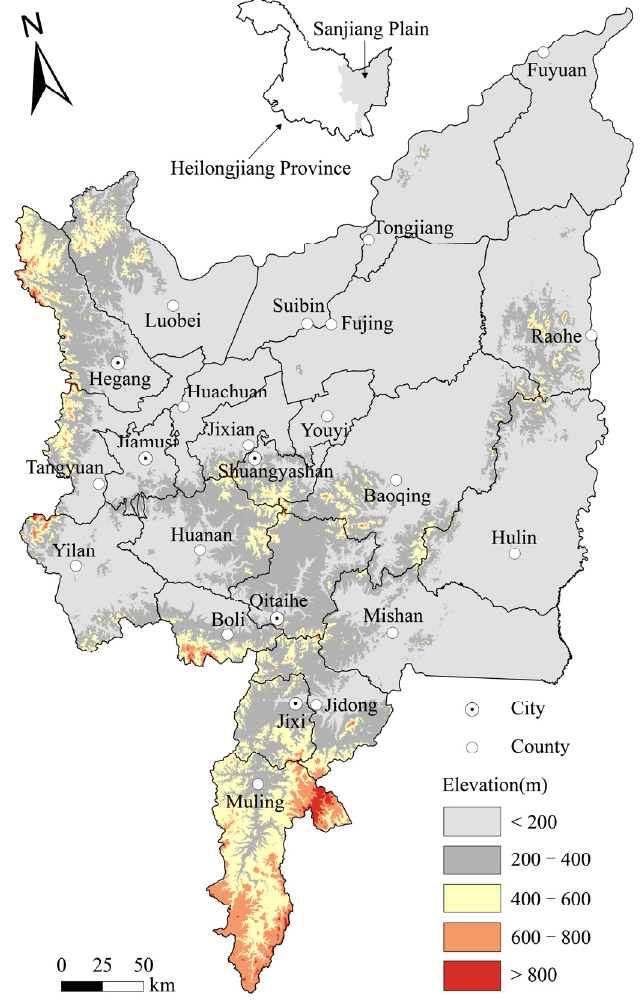
Figure 1. Study area.